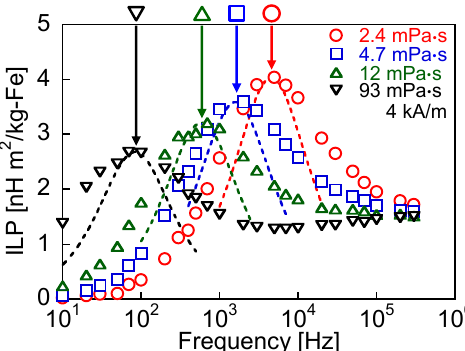
Figure 2. Frequency dependence of the intrinsic loss power (ILP), estimated from the area of alternating current (AC) hysteresis loops for viscosities of 2.4, 4.7, 12, and 93 mPa ∙ s. The corresponding measured ILP peaks are 4.6, 1.6, 0.6, and 0.084 kHz, respectively. The dotted curves are the fitting curves calculated using Equation (10) and the normalization of the calculated ILPs with respect to the measured ILPs at the relaxation peak frequencies. Table 1. Theoretical and measured peak frequencies and relaxation times. The theoretical values for Brownian and Néel relaxations were calculated using Equations (1), (2) and (4). The anisotropic constant is 11 kJ/m 3 . The measured values for the Brownian relaxation were estimated according to Figure 2. Brownian Relaxation Néel Relaxation Frequency Relaxation Time Frequency Relaxation Time (kHz) (ms) (MHz) (ns) Viscosity (mPa ∙ s) Theoretical Measured Theoretical Measured Theoretical Theoretical